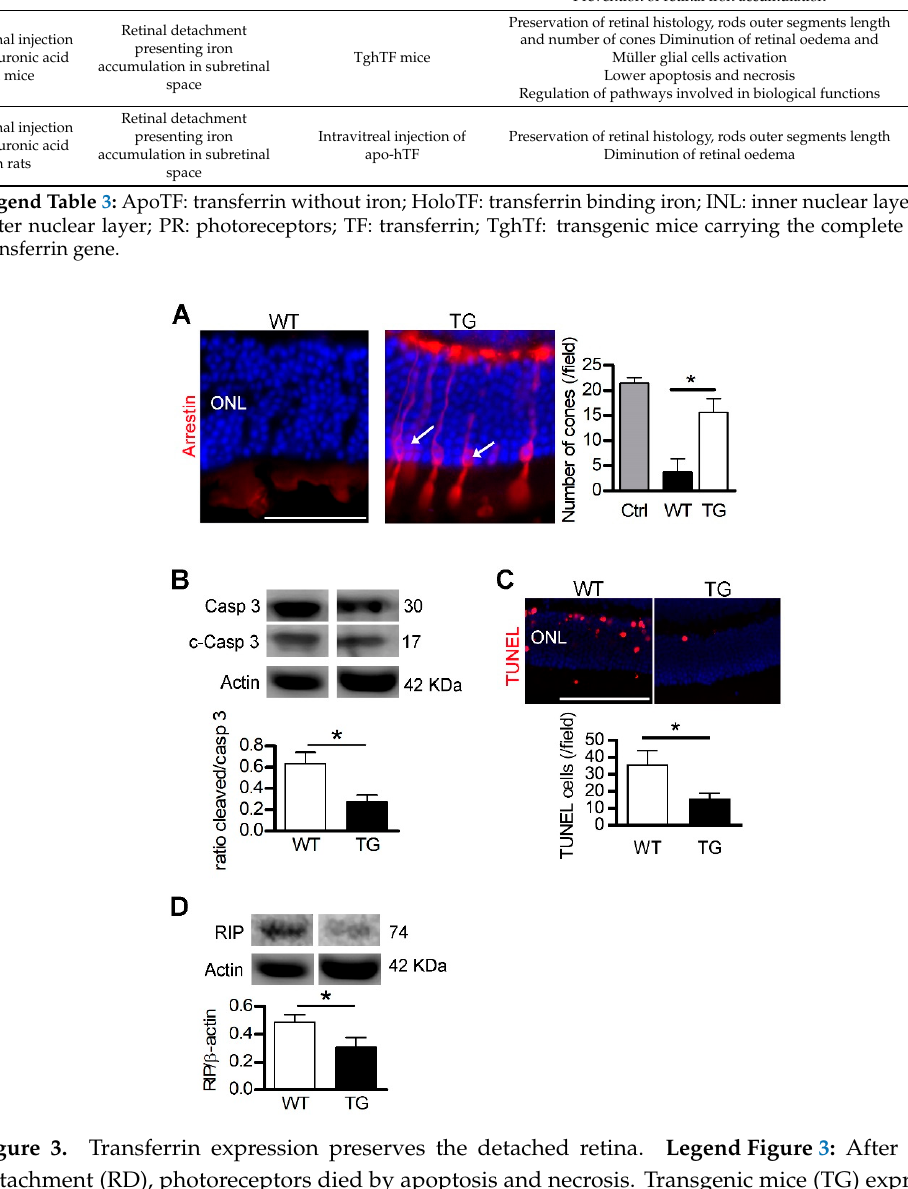
Figure 3. Transferrin expression preserves the detached retina. Legend Figure 3: After retinal detachment (RD), photoreceptors died by apoptosis and necrosis. Transgenic mice (TG) expressing human transferrin (TF) were used to demonstrate the protective effects of TF. ( A ) Arrestin staining revealed cones in retinal sections of TG mice (arrows) after RD. Cone number was higher in TG compared with WT mice. ( B ) The ratio of cleaved/pro–caspase 3 protein level was lower in TG mice compared to WT mice after RD. ( C ) The number of nuclei positive apoptotic-DNA breaks, stained by TUNEL, was reduced in TG mice compared to WT mice. ( D ) Necrotic RIP kinase protein level was reduced in TG mice compared with WT mice. All values are represented as the mean ± SEM. Mann–Whitney test ( n = 3–6), * p ≤ 0.025. ONL: Outer nuclear layer. Scale bar, 100 µ m. From [105]. Reprinted with permission from